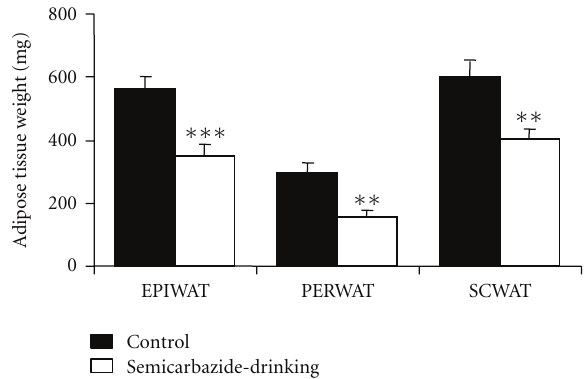
Figure 2: E ff ect of chronic semicarbazide ingestion on adipose tissue mass in male mice. Mean ± SEM of 8 determinations of epididymal (EPIWAT), perirenal + retroperitoneal (PERWAT), or inguinal (SCWAT) fad pad weights. Di ff erent from corresponding control (black columns) at ∗∗ P < . 01, ∗∗∗ P < . 001.